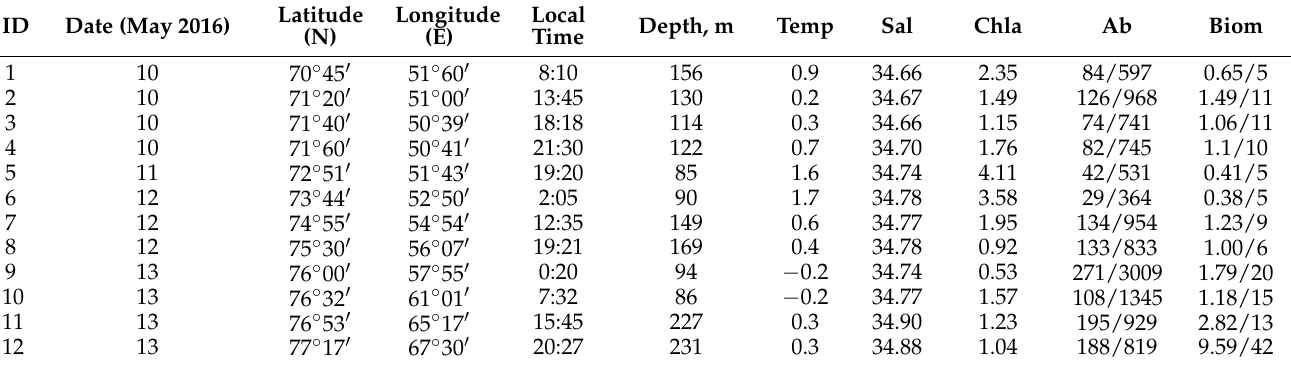
Table 1. Properties of the stations visited in the eastern Barents Sea in May